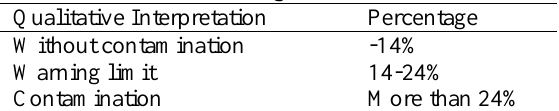
Table 1. TPM waste oil